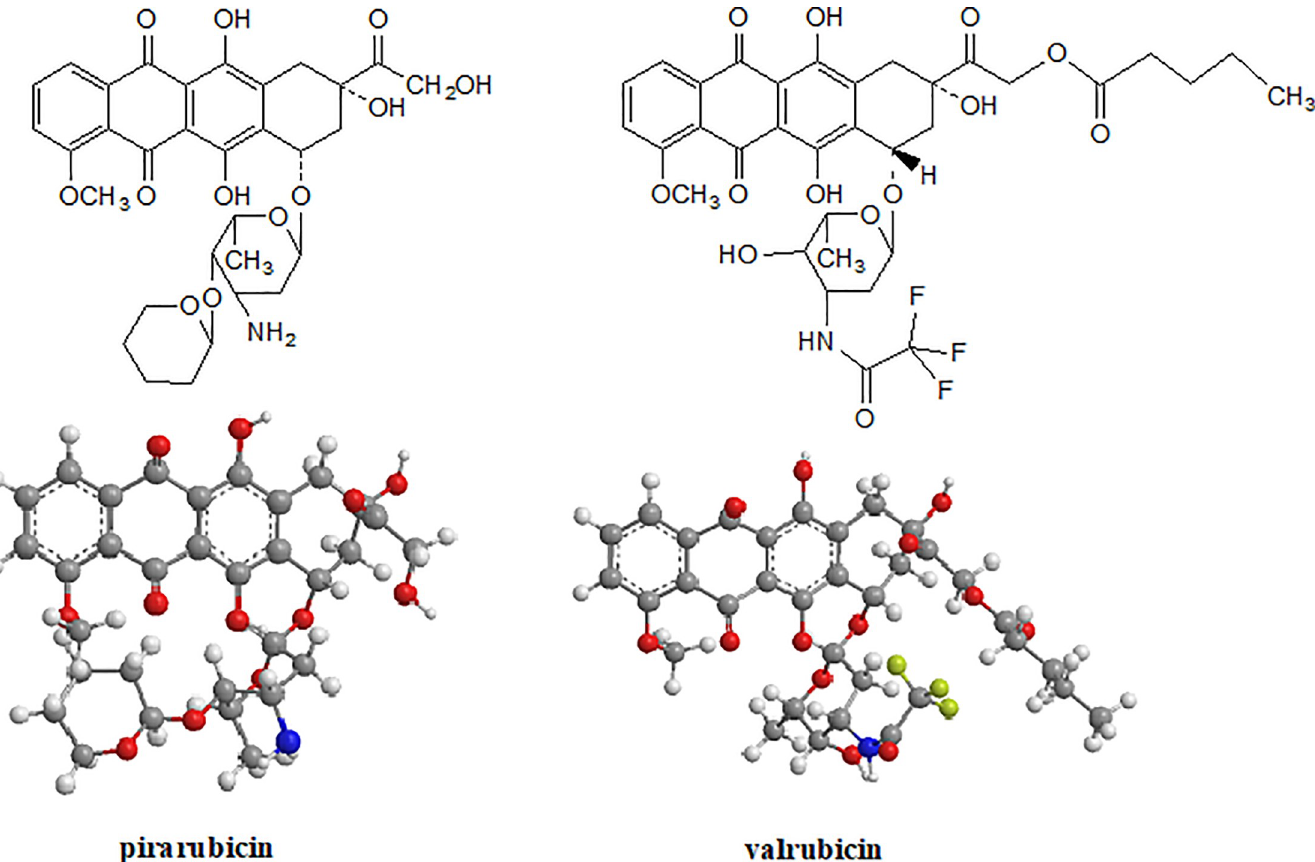
Fig 1. Chemical structures and 3D models of pirarubicin a valrubicin pertaining to the group of anthracycline glycosides.